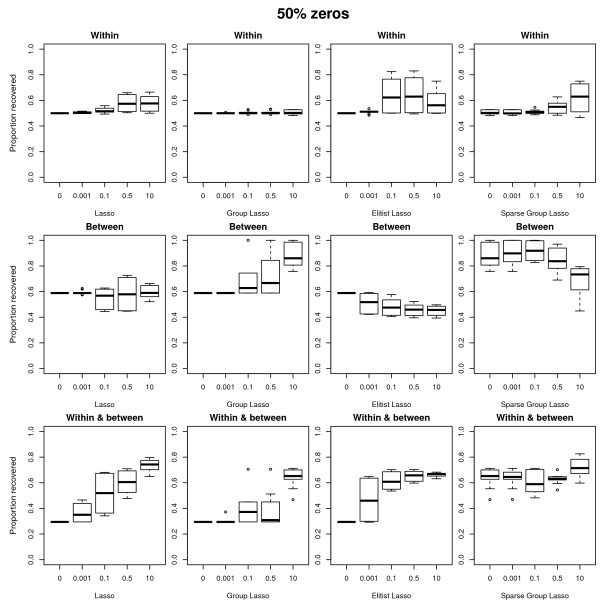
Boxplots of the proportion of recovered variables: 50 percent of true zeros. Boxplots of the proportion of variables correctly classified (selected versus dropped) in function of the value of the tuning parameters. Case with 50 percent of the variables dropped. The different panels refer to the different combinations of structure in the variable selection (from top to bottom: within blocks, between blocks, within and between blocks) and of sparseness approach (from left to right: lasso, group lasso, Elitist lasso, and sparse group lasso). The panels referring to the sparse group lasso are with varying values for the lasso tuning parameter and with the group lasso tuning parameter fixed at f = 10.